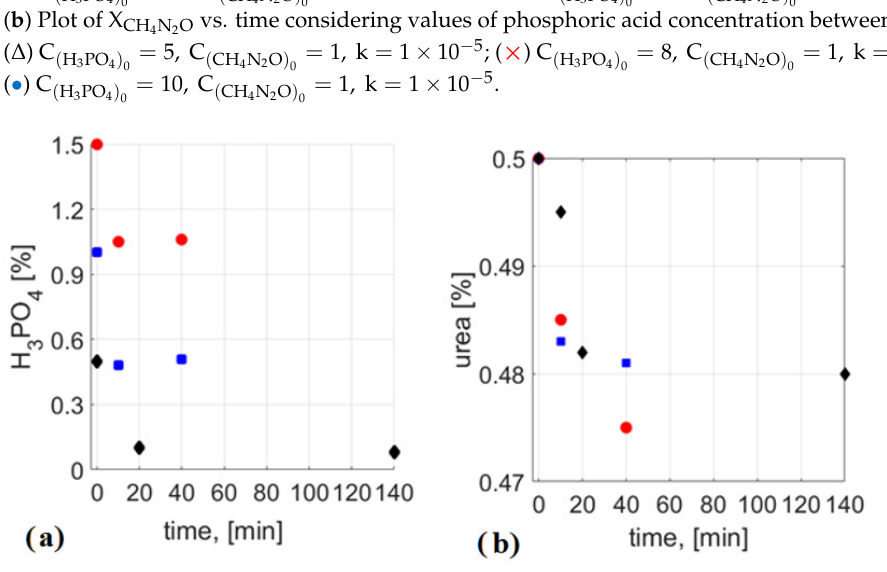
(cid:3404) (cid:3119) (cid:2900)(cid:2899) (cid:3120) (cid:4667) 𝟎